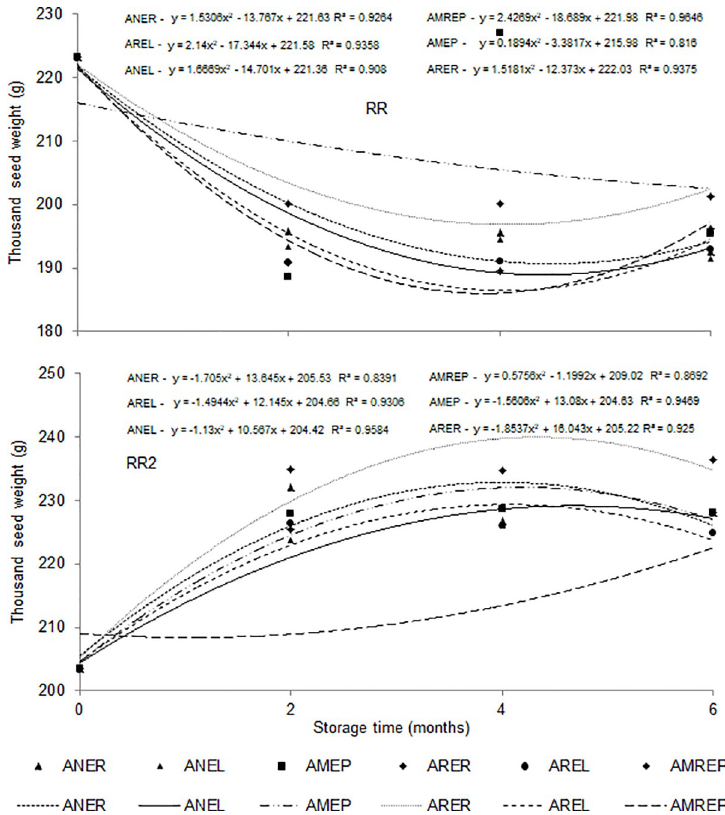
Fig 5. Weight of a thousand soybean seeds (g) from cultivar RR and RR2 as a function of different conditions and storage time. Ambient air + raffia packaging—ANER, Ambient air + packaging laminate packaging—ANEL, modified atmosphere (-14 PSI) + polyethylene packaging—AMEP, refrigerated atmosphere (1 to 3˚C) + raffia packaging— ARER, refrigerated atmosphere (1 to 3˚C) + laminate packaging—AREL, modified atmosphere (-14 PSI) + polyethylene packaging + refrigerated (1 to